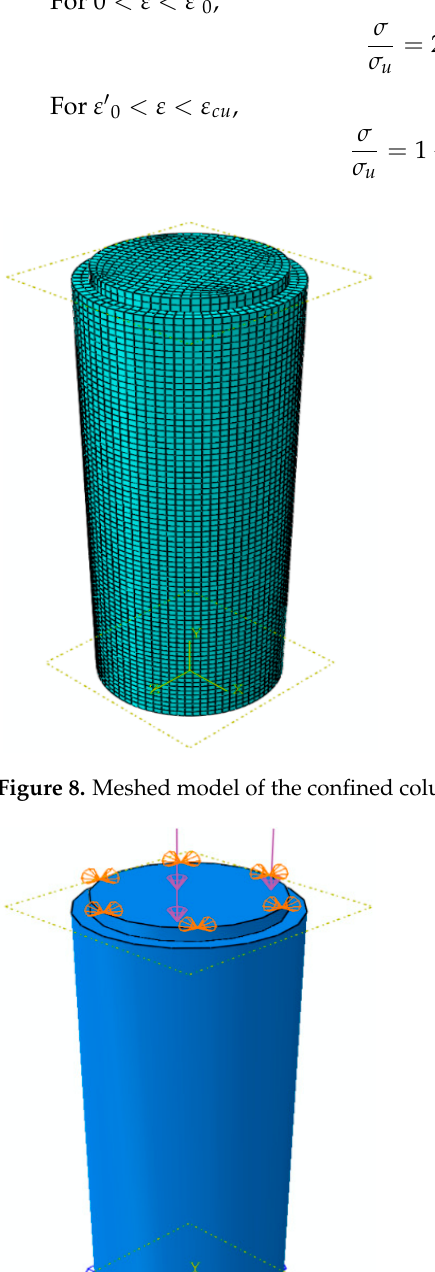
Figure 10. Interaction between PVC inner surface and side surface of the concrete.